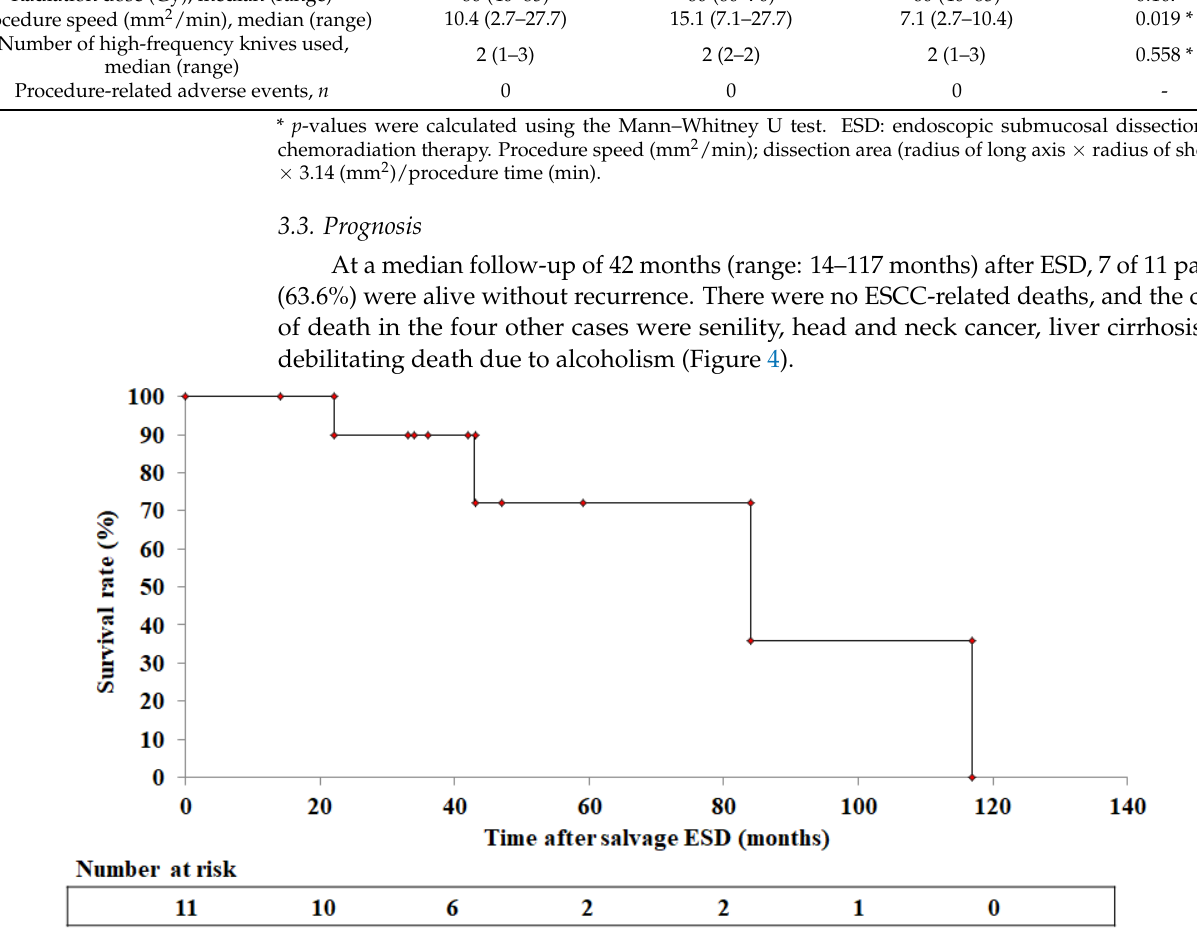
Table 2. Relationship between ESD results and Fibrosis scores.